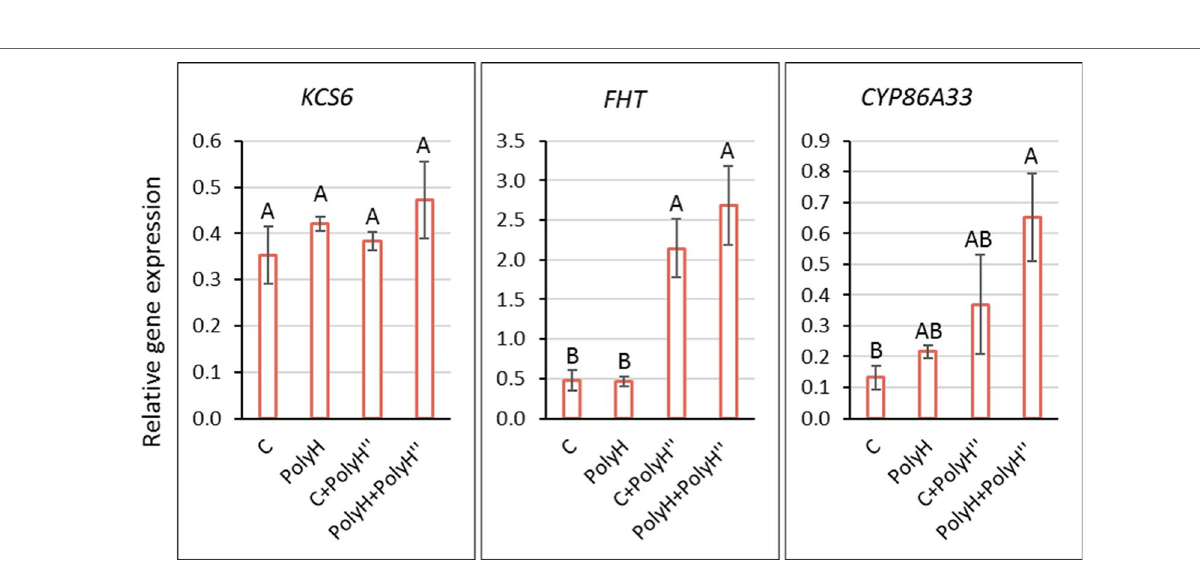
FIgURE 3 | Expression of KCS6 , FHT , and CYP86A33 indicator genes for skin suberization in the peel of Rosanna tubers from experiment 1. Samples labeling is as described in legend of Figure 1 . Peel samples were collected at harvest (135 DATP). Transcript levels were monitored by qPCR and expression levels were normalized relative to that of the reference gene α - NAC . Values are averages of three replicates with SE. Data were analyzed for statistical significance by Student’s t -test; different letters indicate significantly different values ( P <